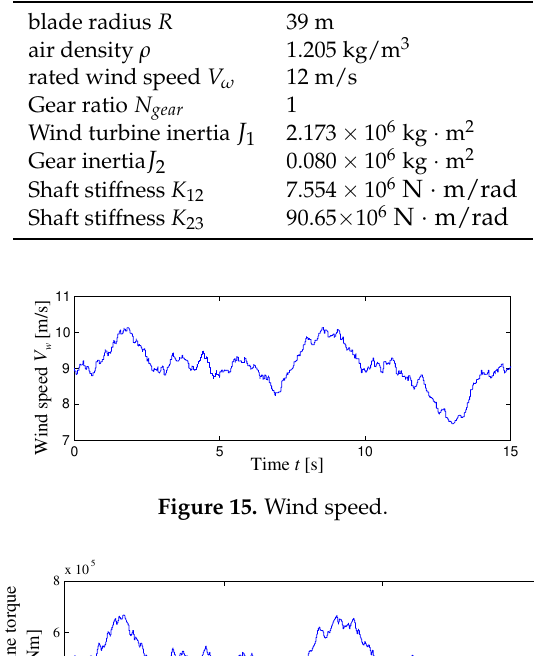
( b ) Torsional torque T 12 .